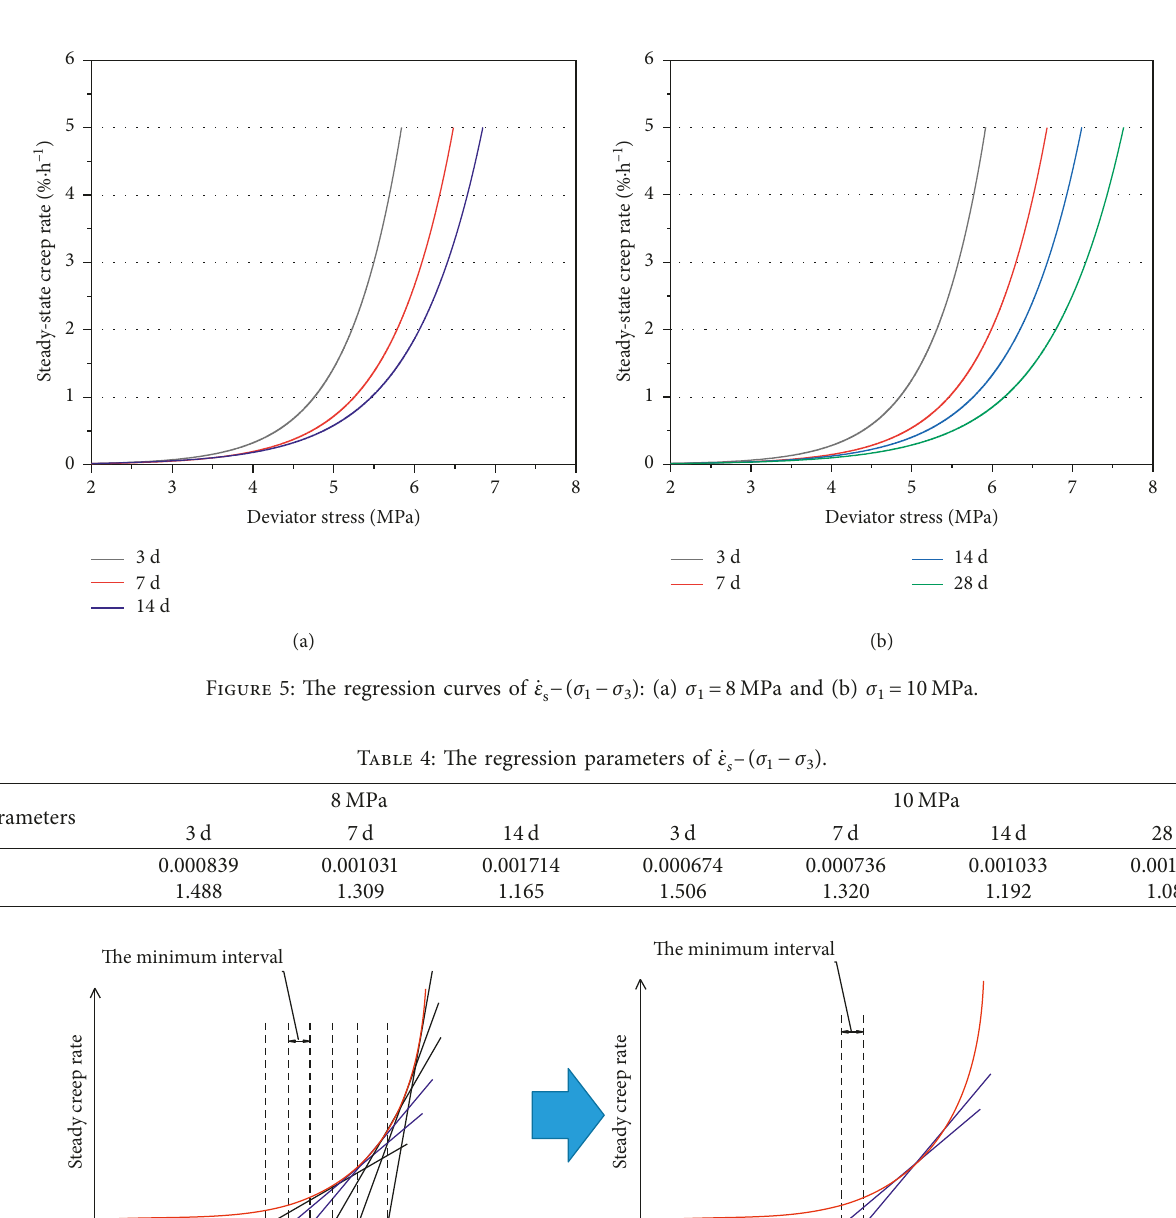
Figure 6: The method used to obtain the long-term Table 5 σ represents the instantaneous strength, and σ f represents the long-term strength. The strength decay rate is − σ expressed as σ , i.e., σ � ( σ )/ σ . f f ∞ f